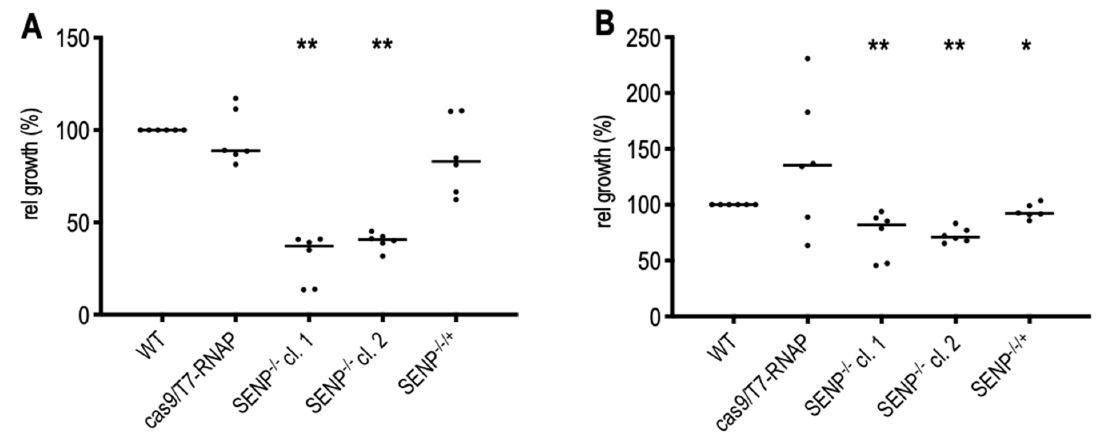
Figure 6. In vitro growth of wild type and mutant L. donovani . Cells were seeded at 5 × 10 5 / mL and grown either at 25 ◦ C / pH 7.0 ( A ) or at 37 ◦ C / pH 7.0 ( B ) for 72 h. Final cell densities were normalized against wild type growth (100%). Bars show the median cell growth. n = 6 (3 biol. repeats, 2 techn. repeats each). ** = p < 0.01; * = p < 0.05 (U-test, two-sided).